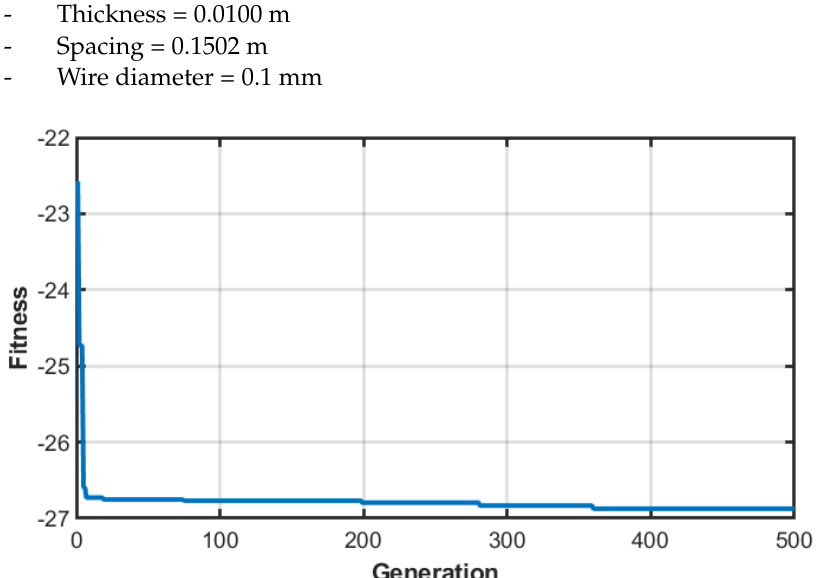
Figure 11. Fitness versus generation, fitness defined as the return losses at central frequency as Equation (31).